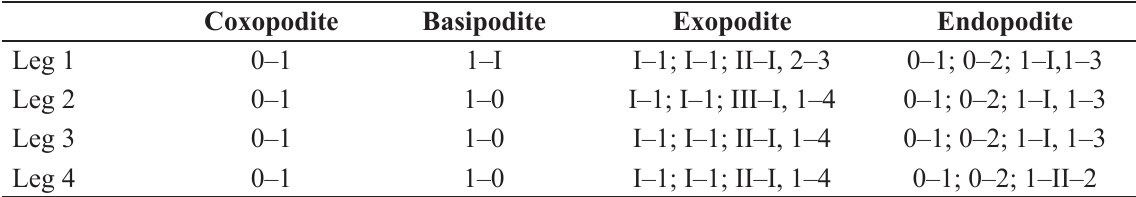
Table 2. armature of legs 1−4 in adult Cyclops bohater koźmiński, 1933. spines are denoted by Roman, setae by arabic numerals. the armature on the lateral margin of any segment is given first, followed by the elements on the apical and medial